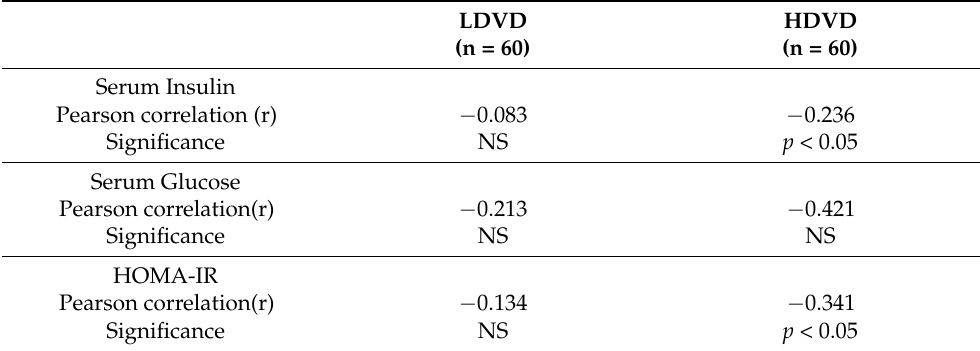
treatment with low and high doses of vitamin